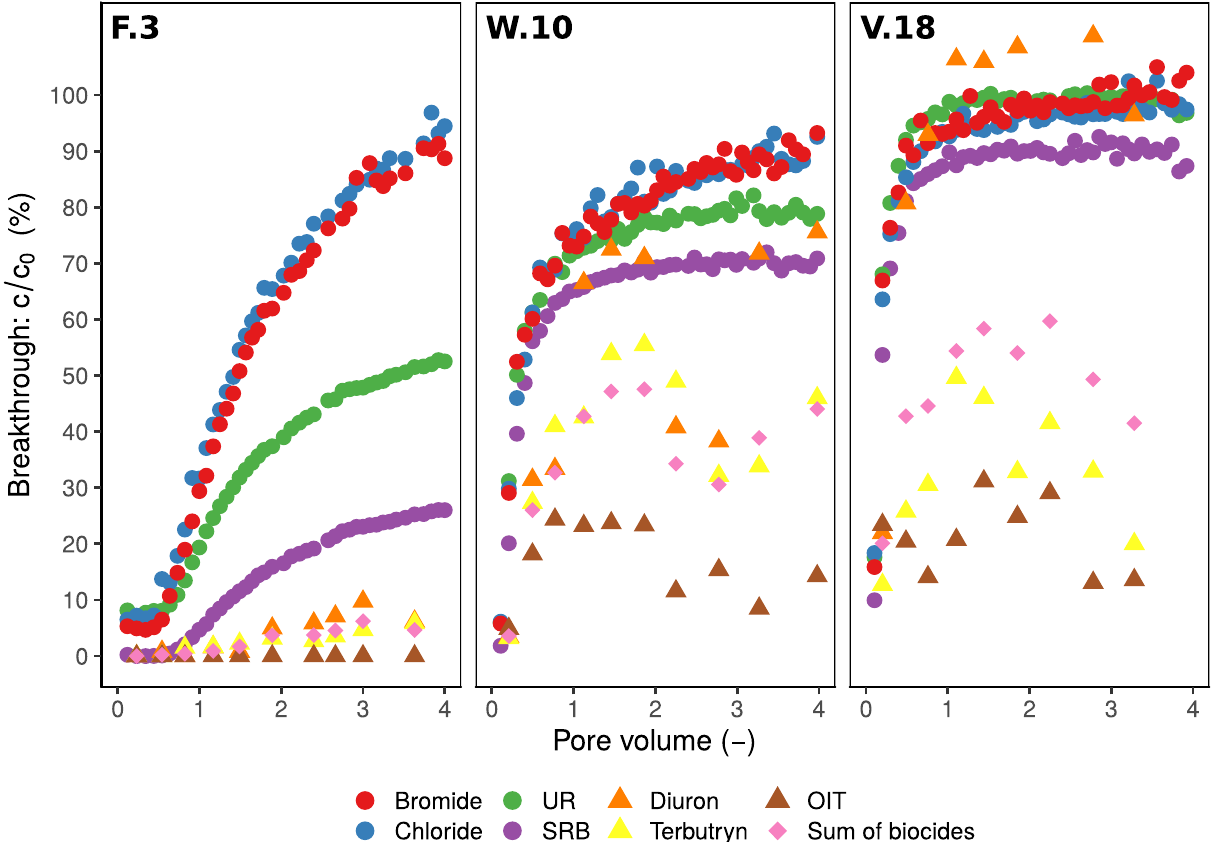
Figure 2. Breakthrough curves (BTCs) of the tracers bromide, chloride, UR, SRB and the biocides diuron, terbutryn, OIT and the sum of biocides (diuron+terbutryn+OIT; represented by diamonds). The normalized concentrations c/ c 0 (%) in the outflow from soil columns was plotted against the pore volume (–).